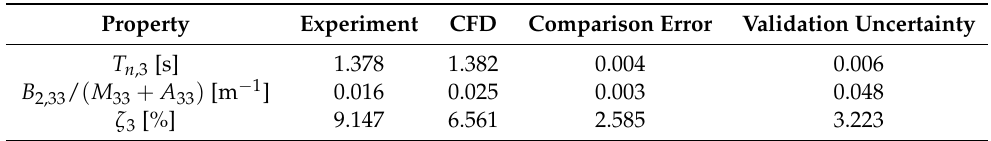
Table 6. Comparison of the free decay test results for heave from experiments and CFD simulations using the quadratic